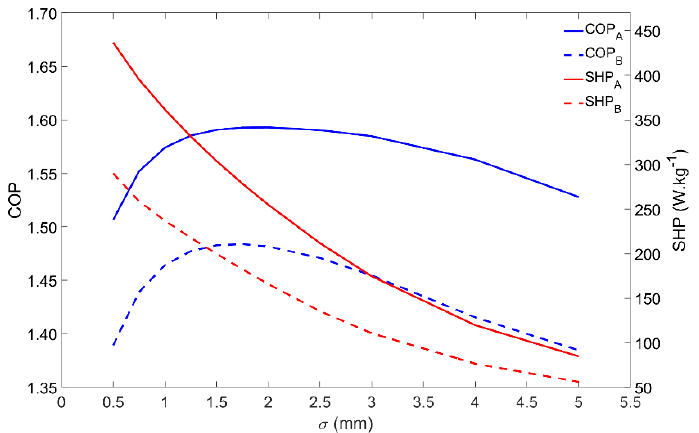
Figure 8. Effect of the adsorbent coating thickness on the adsorber performance for scenarios A and B.